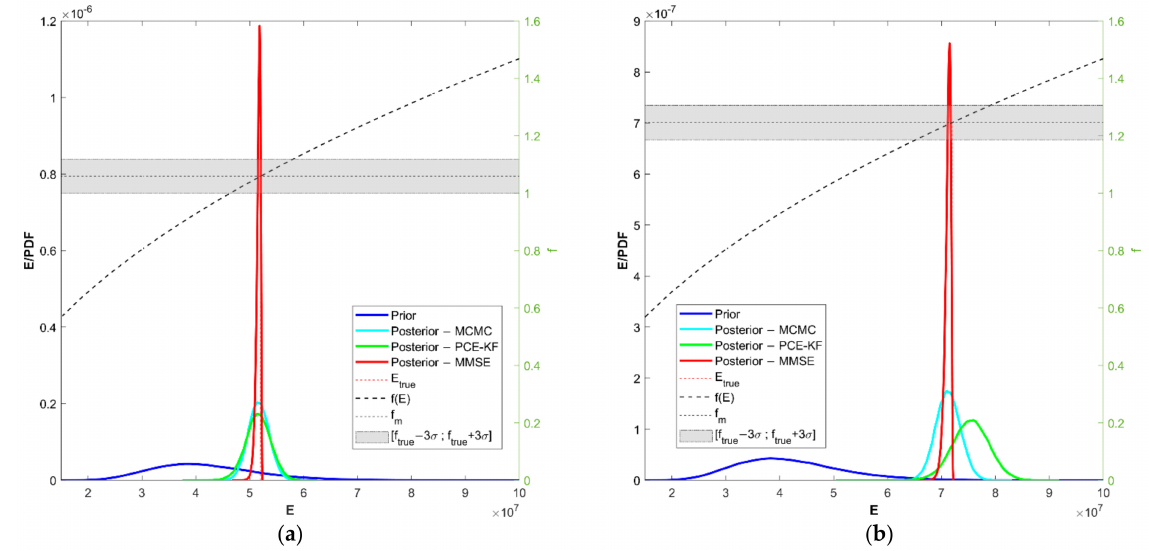
Figure 15. Comparison of updating procedures—concrete water tank: ( a ) E true = E + s E and ( b ) E true = E + 3 s E . In each figure, the following are reported: the prior PDF (in blue); the posterior PDFs obtained via MCMC (in cyan), via PCE-KF (in green) and via NL-MMSE (red solid line); the true value of the parameter E true (red dashed line); the model response f ( E ) (black solid line); the measurement f m (black dashed line); the ± 3 σ ε region of the measurement (grey area).